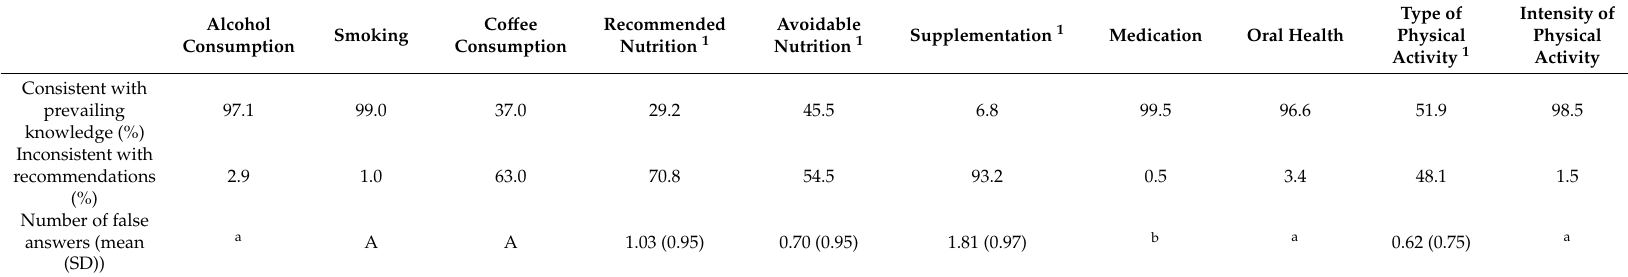
Table 2. Pregnant women’s knowledge of lifestyle-related risk factors during pregnancy ( N = 209).